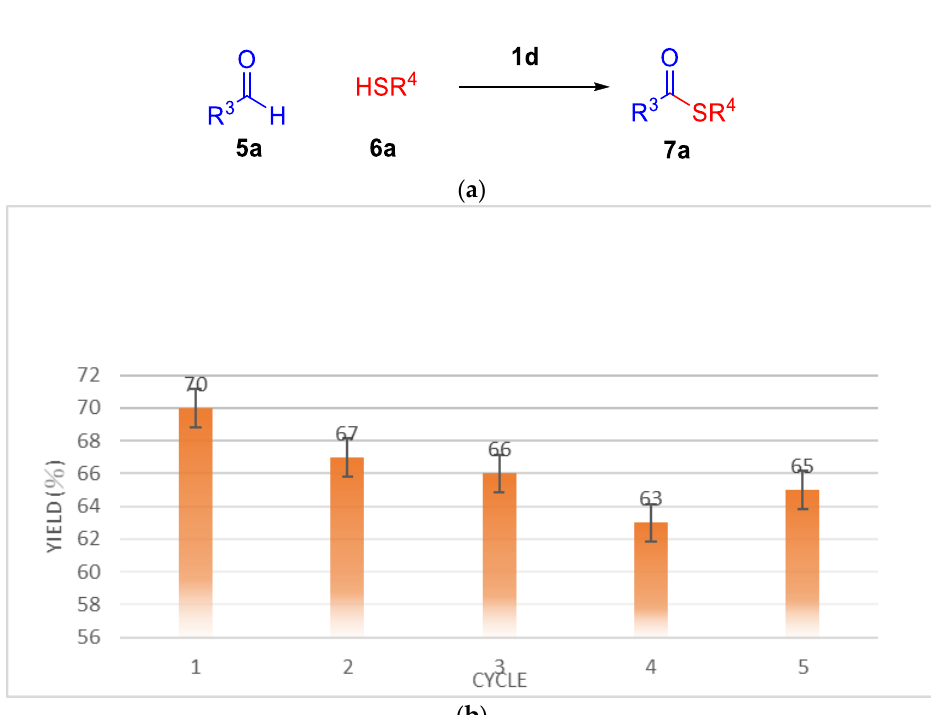
Figure 4. ( a ) Thioesterification reaction of thiols ( b ) Recycling of ld in the synthesis of S-Dodecyl benzothioate. Molecules 2020 , 25 , x FOR PEER REVIEW